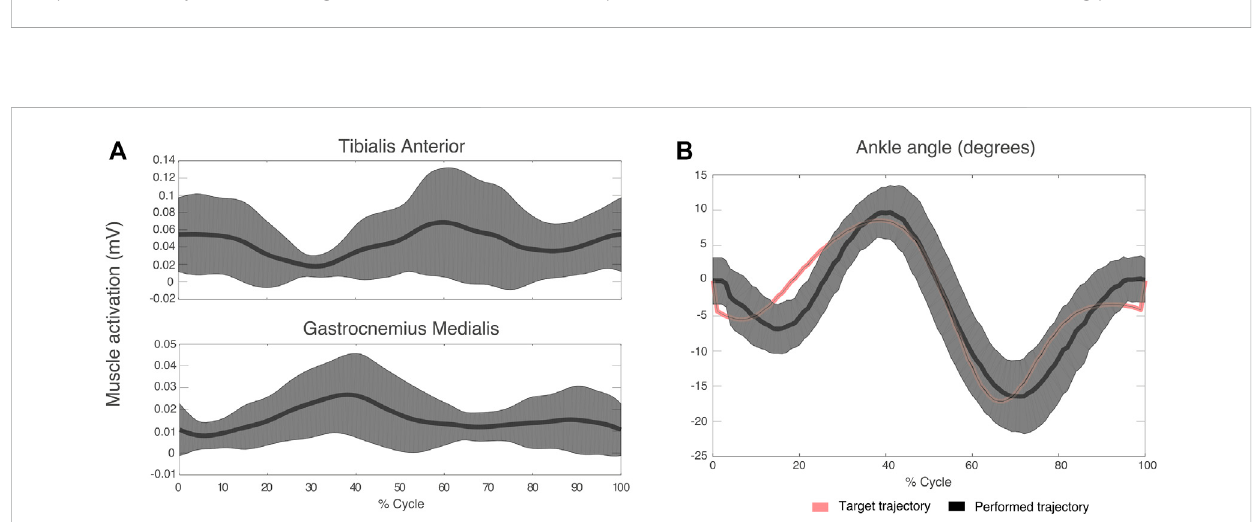
FIGURE 5 (A) Mean (thick lines) and standard deviation (shaded areas) of EMG envelopes from the tibialis anterior and gastrocnemius medialis of a representative subject (ID 09) during the StC trial. (B) Target and performed ankle angle during the StC trial for the same subject as in (A) . Positive angle indicates dorsi fl exion direction and negative angle indicates planta fl